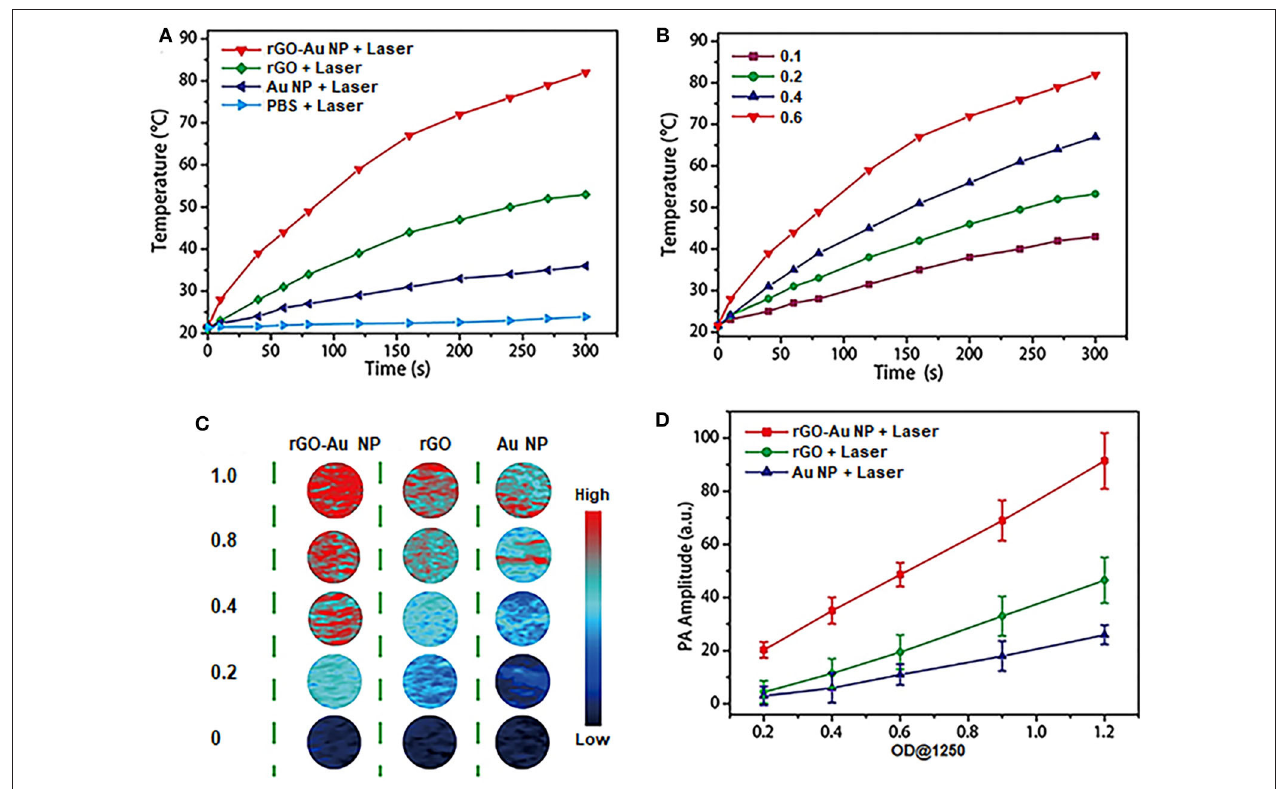
FIGURE 2 | NIR-II photothermal and photoacoustic properties of rGO-AuNP nanocomposite. (A) Temperature variations of PBS, rGO, the mixture of rGO and AuNP and rGO-AuNP PEG irradiated with a 1,061nm laser at a power density of 0.5 W/cm 2 as a function of time. (B) Temperature increase curves of the rGO-AuNP at different concentrations irradiated with laser. (C) Photoacoustic images of rGO, AuNPs, and rGO-AuNP aqueous solutions at different concentrations. (D) PA intensities of rGO, AuNPs, and rGO-AuNP aqueous solutions illuminated with 1,250nm laser as a function of OD 1250